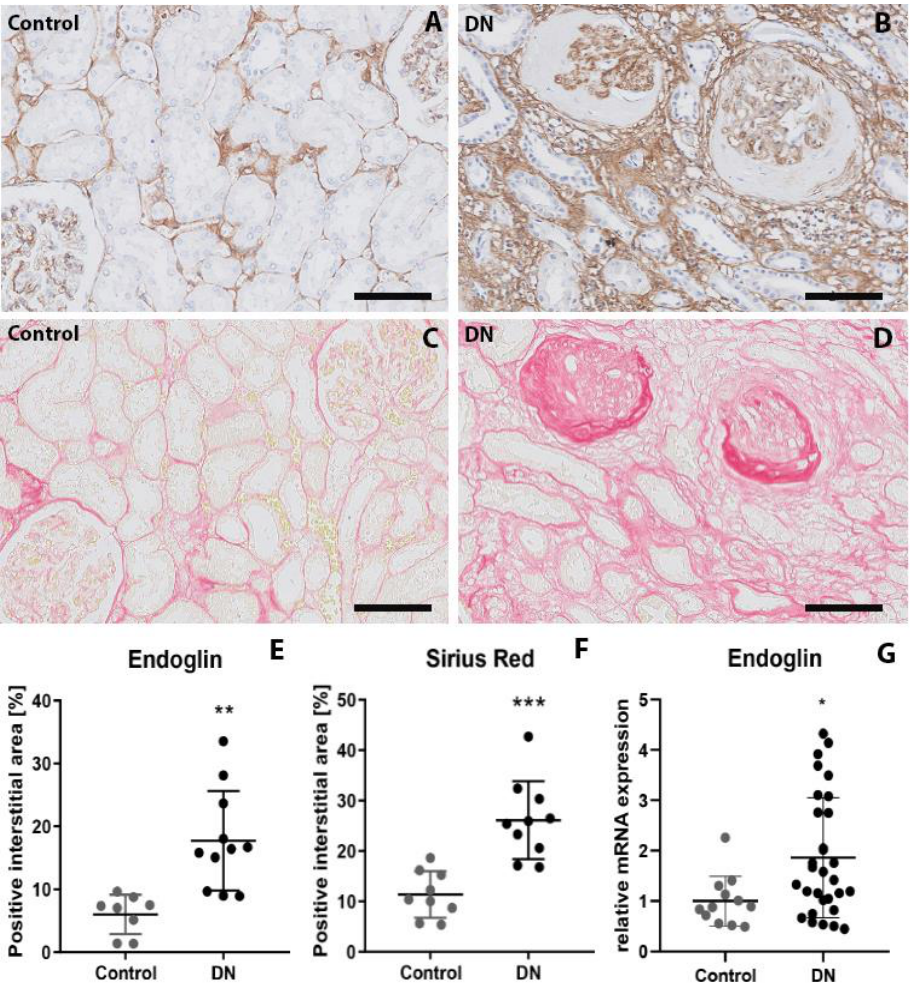
Figure 2. Endoglin expression is increased in the interstitium in biopsies of patients with DN. Representative images of endoglin staining ( A and B ) and Sirius Red staining ( C and D ) in kidney biopsies from non-diabetic controls ( A and C ) and patients with DN ( B and D ). Summary data for the endoglin-positive area ( E ) and Sirius Red‒positive area ( F ) are also shown. ( G ) mRNA expression levels of endoglin in whole kidney lysates derived from biopsies of patients with DN. The housekeeping gene HPRT was used as a control. * p < 0.05, ** p < 001 and *** p < 0.001 (Student’s t-test). The scale bars represent 50 µm.